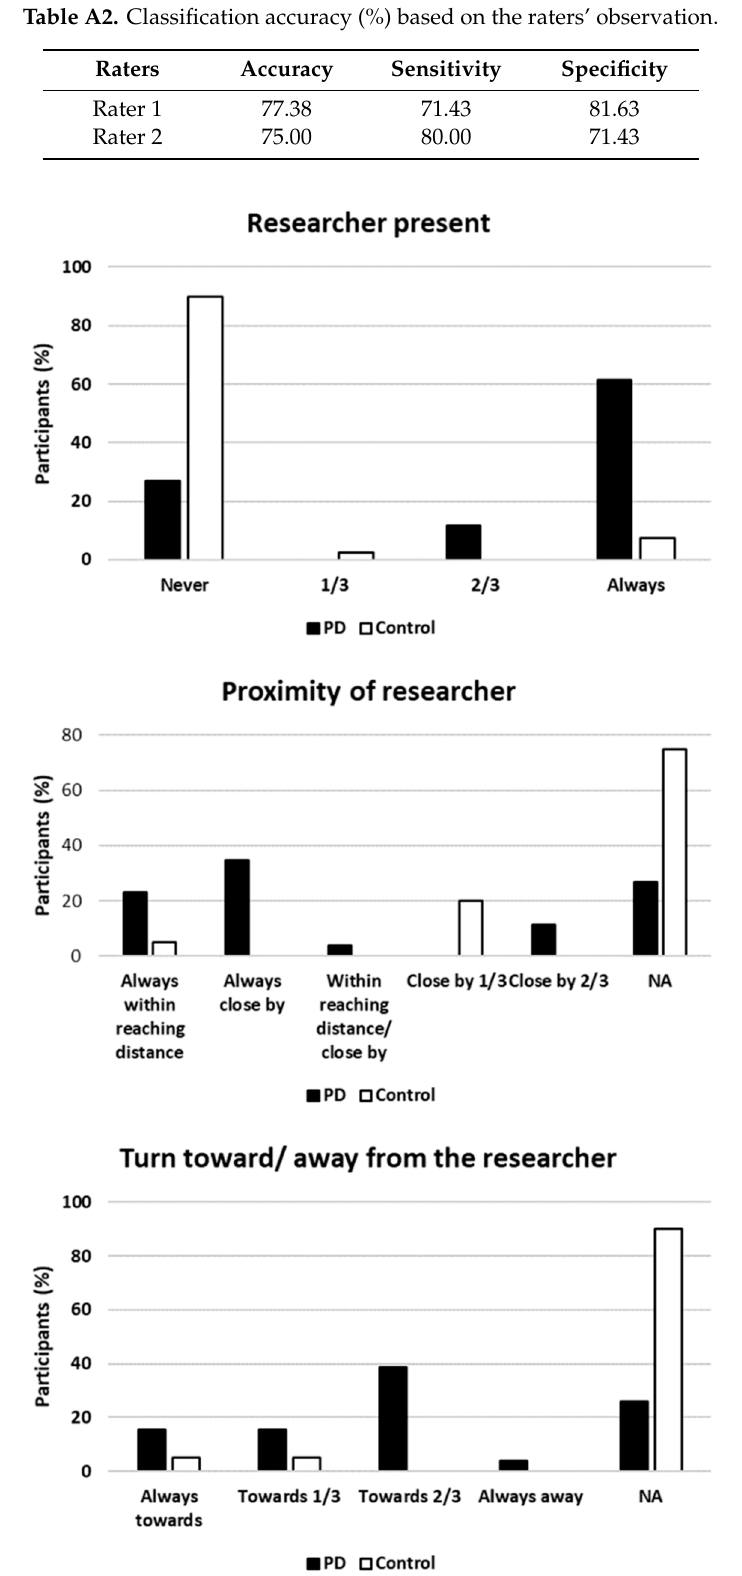
Figure A1. Bar charts presenting the proportion of PD and CL participants who completed the walking assessment with a researcher beside them, the proximity of the researcher and turn direction relative to the researcher (1/3 denotes 1 of 3 trials; 2/3 denotes 2 of 3 trials).